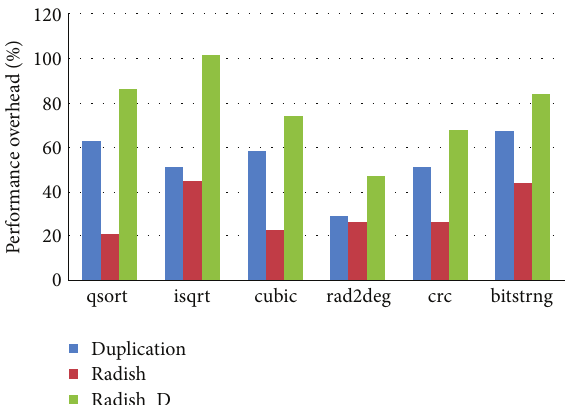
Figure 4: The comparison of performance overheads among full instruction duplication, Radish, and Radish D.